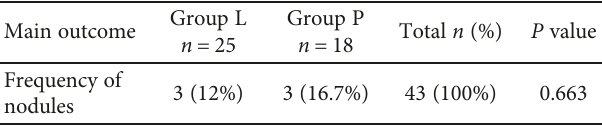
Table 2: Comparison between the frequency of nodules in groups L and P 6 years after the conclusion of the RCT